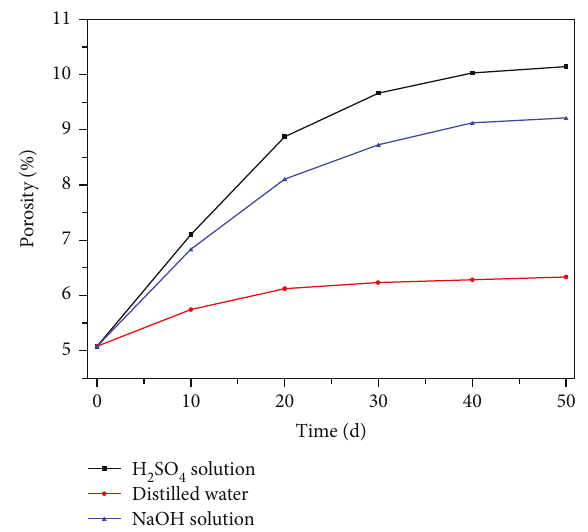
Figure 4: Change curves of average porosity of sandstone specimens with di ff erent times of immersion in chemical